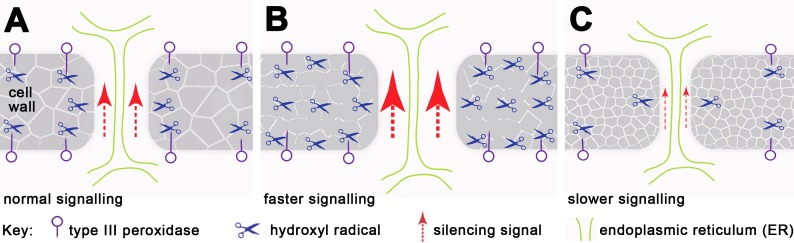
Working model for regulation of silencing spread by peroxidases around PD.Each panel represents a single PD traversing the cell wall. (A) Cell wall-localised Type III peroxidases maintain H2O2 through hydroxylic and peroxidative cycles (reviewed in Passardi, Penel & Dunand, 2004), in which H2O2 modifies cell wall components via cross-linking and depolymerization, thus maintaining a functional cell wall network and PD size. (B) With increased H2O2, the cell wall undergoes depolymerization and loosening, allowing PD to enlarge, with increased transport capability through the cytoplasmic sleeve (data based on this work and Benitez-Alfonso et al., 2009; Stonebloom et al., 2009; Stonebloom et al., 2012). (C) Reduced H2O2 or mutation in peroxidase-dependent cross-linking or depolymerization causes cell wall stiffening, and presumably also reduces PD apertures (this work and Fry, 1998; Schweikert, Liszkay & Schopfer, 2000; Schopfer, 2001; Liszkay, van der Zalm & Schopfer, 2004; Passardi, Penel & Dunand, 2004; Muller et al., 2009).